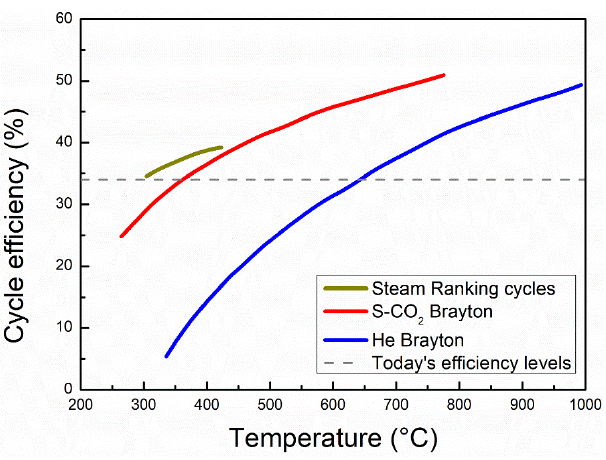
Figure 1. Comparison of theoretical efficiency in different systems. Data were obtained from reference [3].